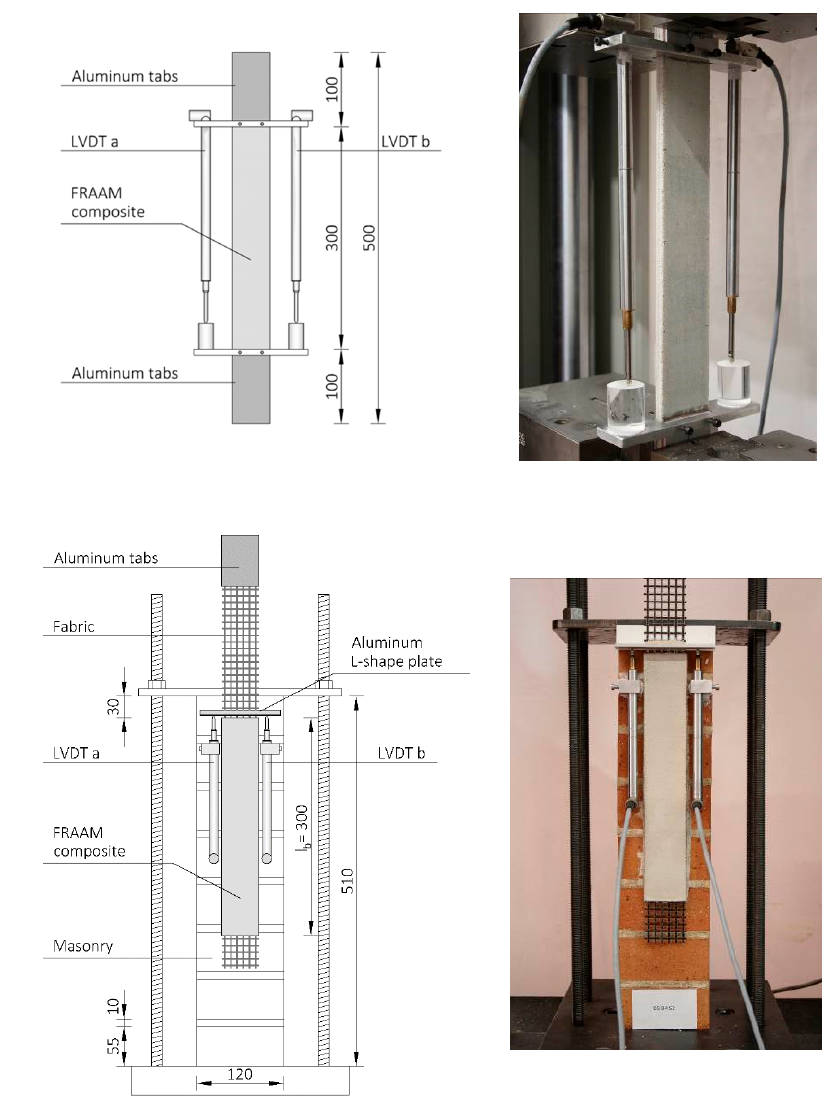
Figure 3. Test setup: ( a ) tensile test scheme and ( b ) single-lap shear test (dimensions in mm) .